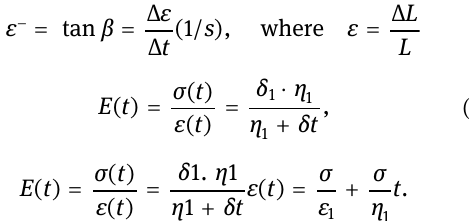
Figures 6 and 7 illustrate creep behavior ( strain vs fi sh scales at temperature of 20 and 26°C, respectively.